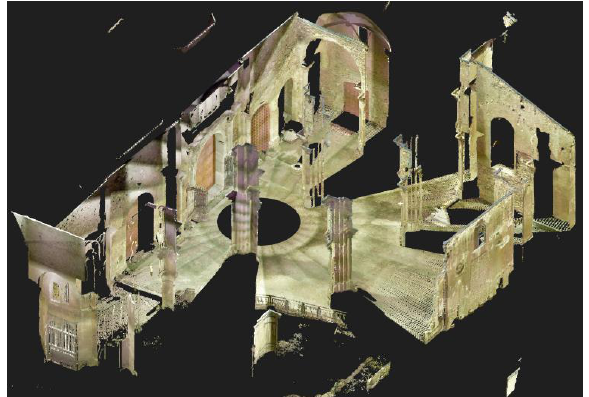
Figure 4. View of the textured point cloud inside the building.